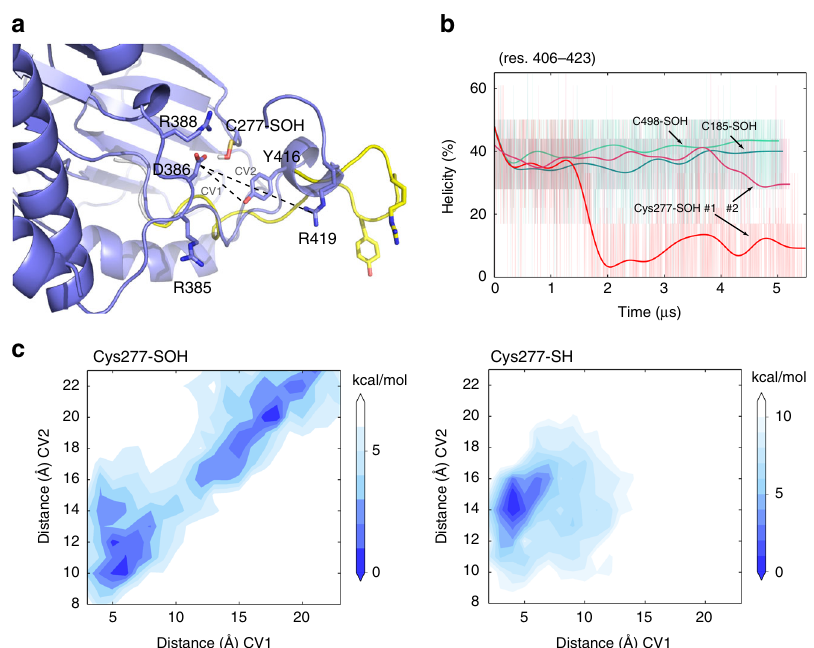
Fig. 4 Cysteine oxidation to Cys-277-SOH promotes unfolding of the Src A-loop α -helix. a A fi nal snapshot of Cys-277-SOH system (purple blue) from MD simulation superposed with it from metadynamics simulation that displays the unfolded conformation of the A-loop (residues 406 – 423, yellow). Detailed structures compared with wild-type group are shown in Supplementary Fig. 12. Key residues that interact with the A-loop region are labeled. b Percent α - helix fold of residues 406 – 423 throughout the MD simulation of Cys-277-SOH system (two replicas labeled as #1 and #2 are in red and pink) in comparison with control groups (green and cyan). c Free-energy landscapes of Cys-277-SOH system and Cys-277-SH system, respectively. Two collective variables (CVs), pair distances of Tyr-416-Asp-386 and Arg-419-Asp-386, are used in metadynamics simulations. Color scale: Cys277-SOH white = 7.0 kcal/mol, blue = 0.0 kcal/mol (left) and Cys277-SH white = 11.0 kcal/mol, blue = 0.0